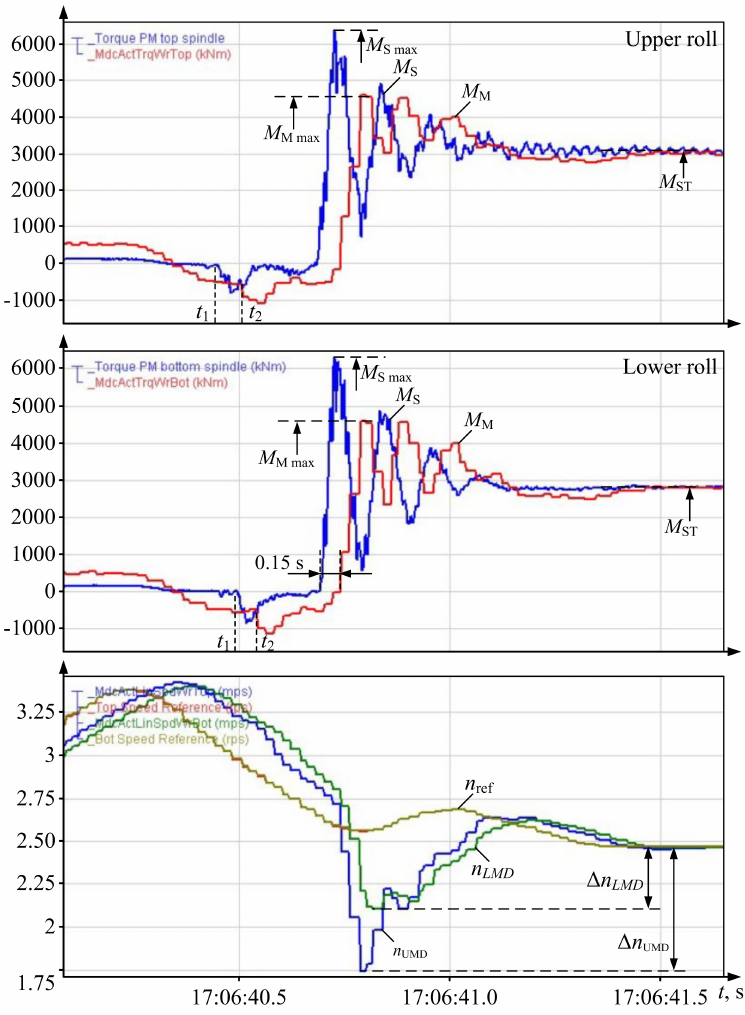
Figure 3. Oscillograms of the motor torques M M , elastic torques M S of spindle shafts, reference speed n ref and actual speeds n UMD , n LMD of the upper/lower roll